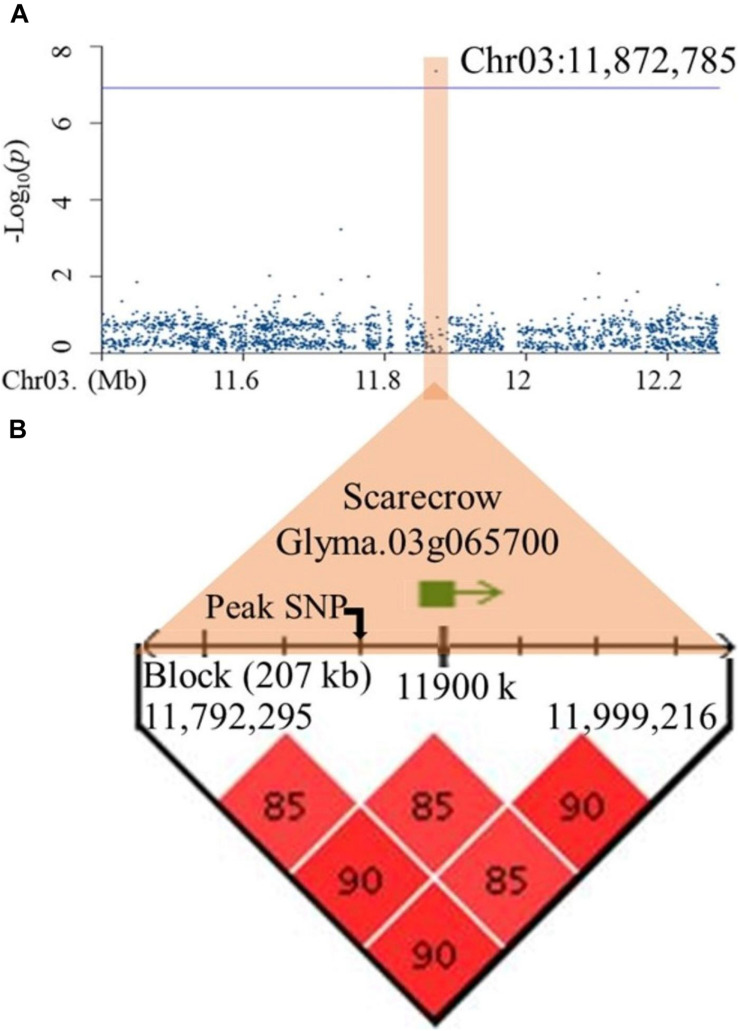
Identification of a candidate gene within the haplotype block containing the peak SNP for qTLR2 on chromosome 3. (A) A regional Manhattan plot (1Mb) representing marker-trait associations on chromosome 3. (B) Haplotype block including the peak SNP (Chr03: 11,872,785) and a candidate gene (Glyma.03g065700) residing in this block.